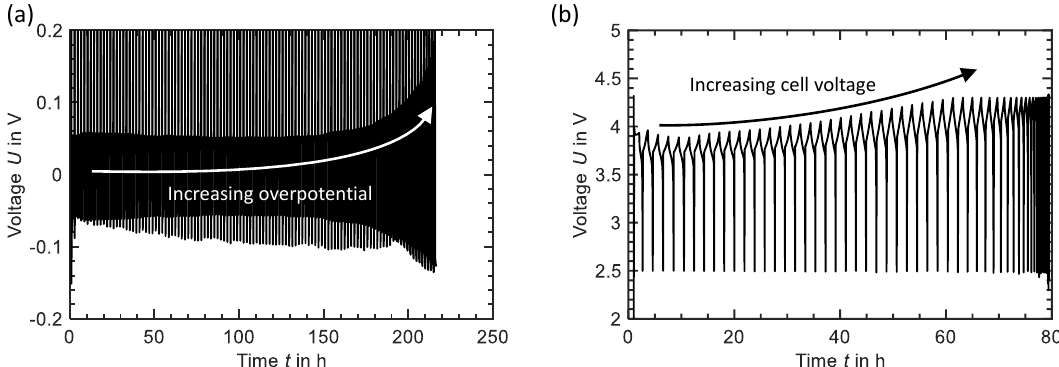
Figure 5. ( a ) Voltage profile of planar Cu foil and Li counter electrode with a Li inventory of C Li = 78mAh/cm 2 with LiPF 6 in EC:DEC:FEC: 4.5:4.5:1. As a result of electrolyte decomposition on both electrode surfaces, Ohmic overpotential increases until a cell defect occurs. ( b ) Voltage profile of planar Cu foil and NCM counter electrode with C NCM = 4mAh/cm 2 with LiPF 6 in EC:DEC:FEC: 4.5:4.5:1